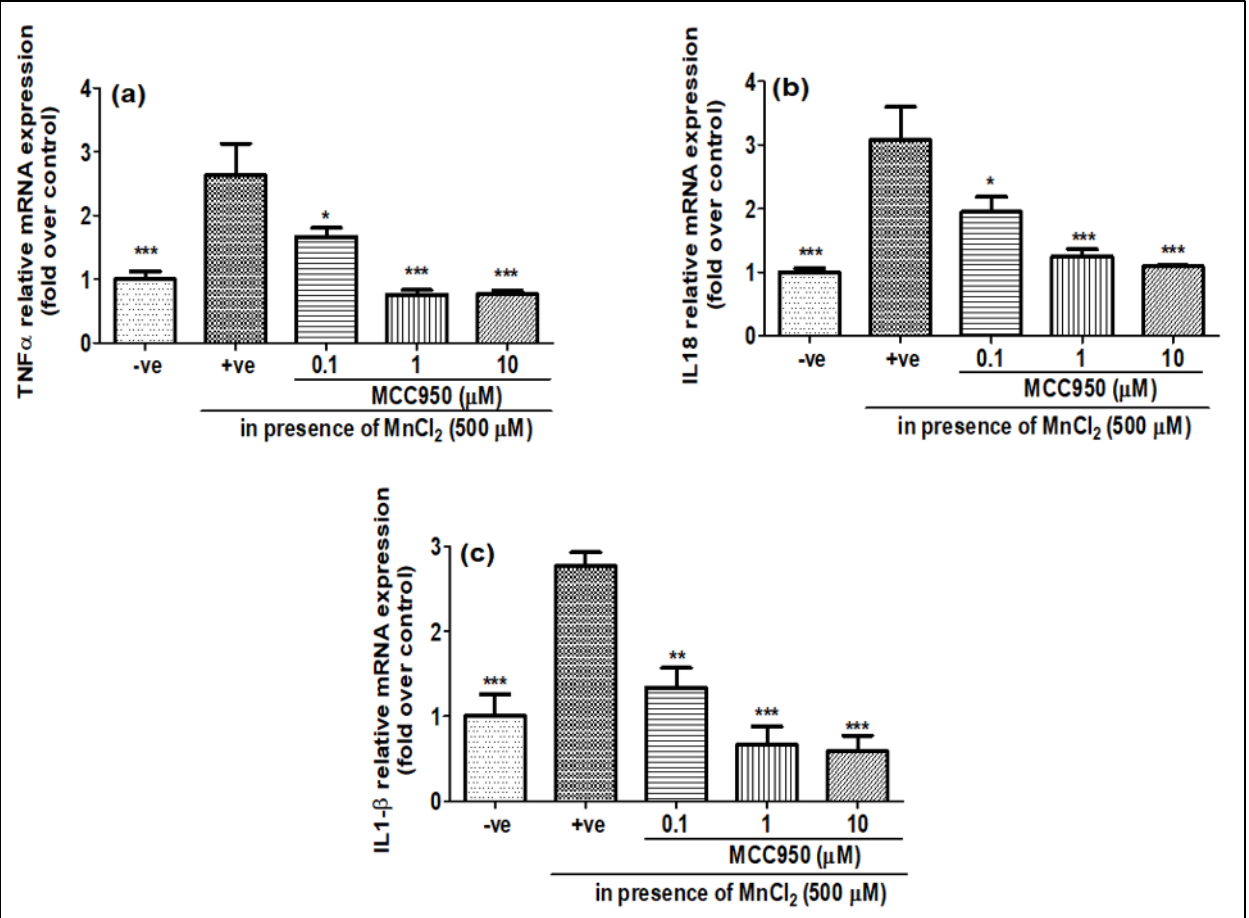
Figure 6. MCC950 was able to inhibit MnCl 2- induced pro-inflammatory cytokines detected by qPCR. N2a cells were pre-treated for 1 h with MCC950 (0.1, 1 and 10 µM) and later exposed to MnCl 2 (500 µM) for 24 h. ( a ) relative TNFα gene expression, ( b ) relative IL-18 gene expression, ( c ) relative IL- 1β gene expression. All mRNA values were normalized to the housekeeping mRNA, GAPDH, and expressed as a fold-induction over the control sample (set at a value of 1). Data represented as mean ± SEM. * p < 0.05, ** p < 0.001, *** p < 0.0001 vs. control group.